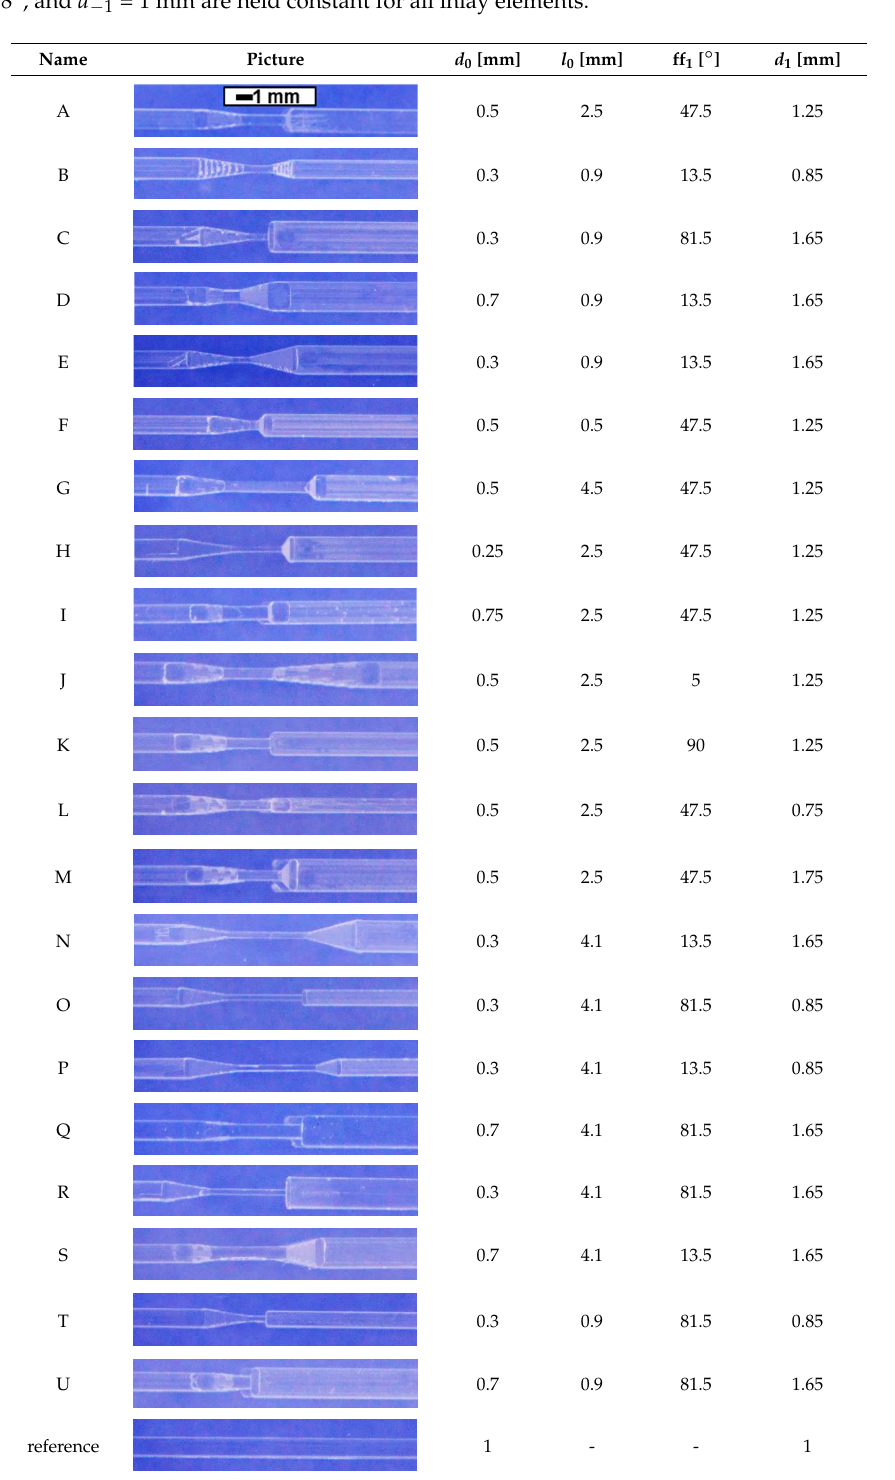
Table 1. Fabricated micronozzle inlay elements for investigation of turbulent bubble breakup. Nozzle parameters are varied as shown. Close up images of the micronozzles are given. T-mixer geometry, α − 1 = 8 ◦ , and d − 1 = 1 mm are held constant for all inlay elements.